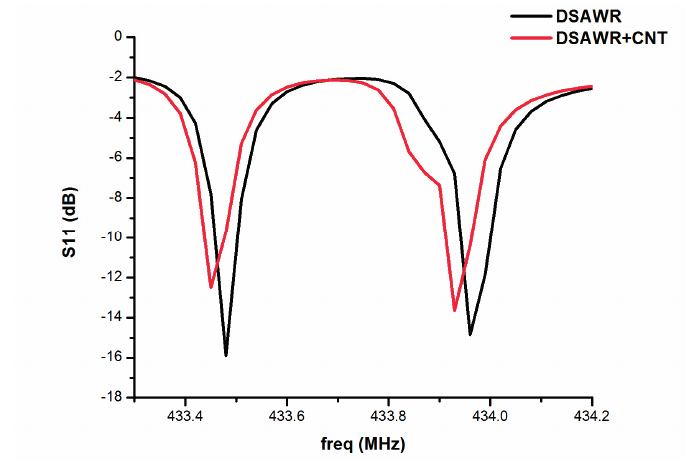
Figure 6. Plot of S11 versus